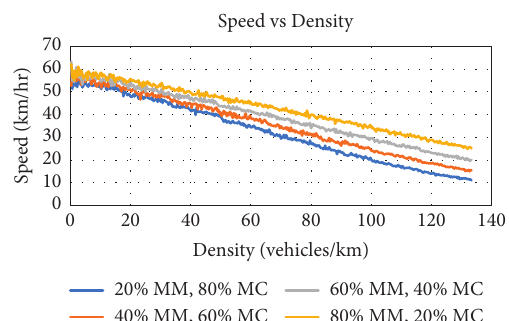
Figure 35: Flow rate vs. density fundamental diagrams for different compositions of MM and MC.